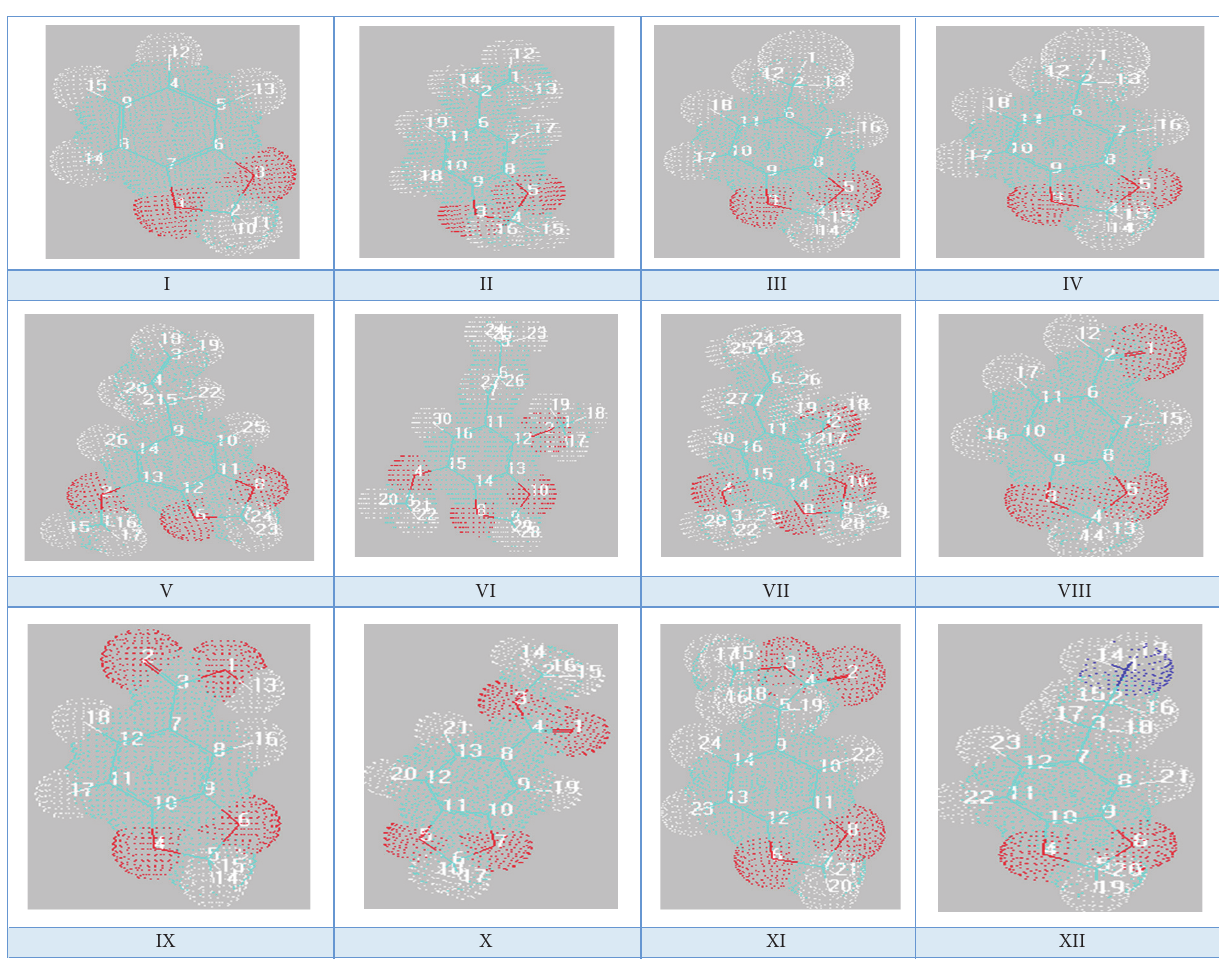
Figure 2: The optimized structure of the investigated 1,3-benzodioxole